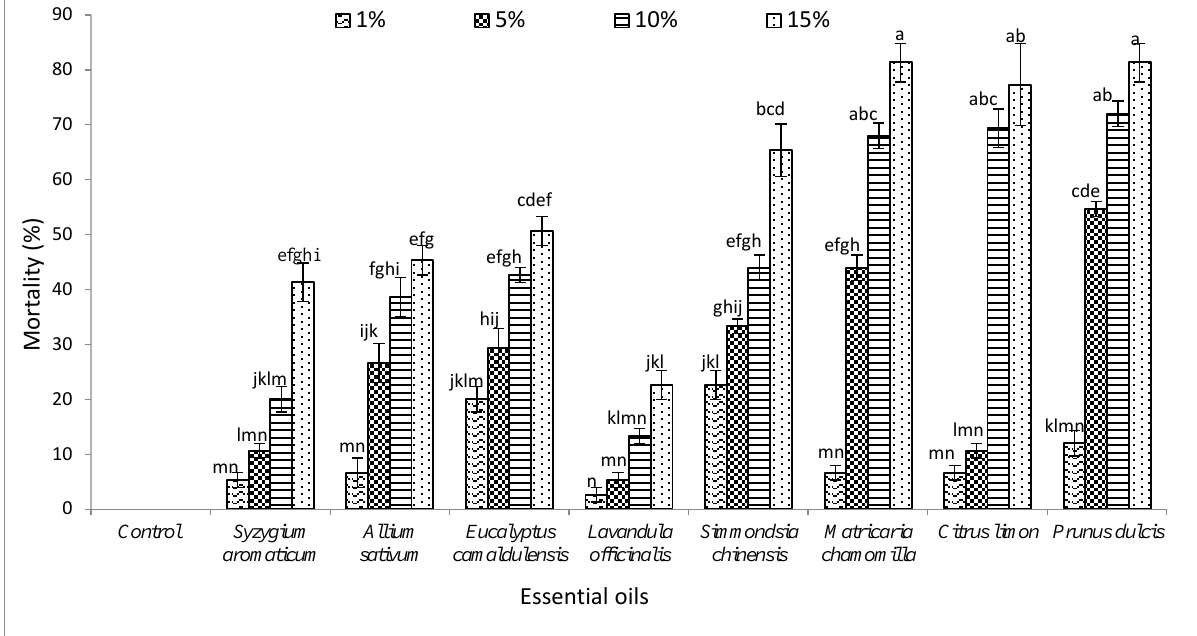
Figure 1. The impact of eight essential oils on the mortality rate of T. castaneum (Herbst) after 24 h of exposure. Different letters above the bars indicate a significant ( P < 0.05) difference.